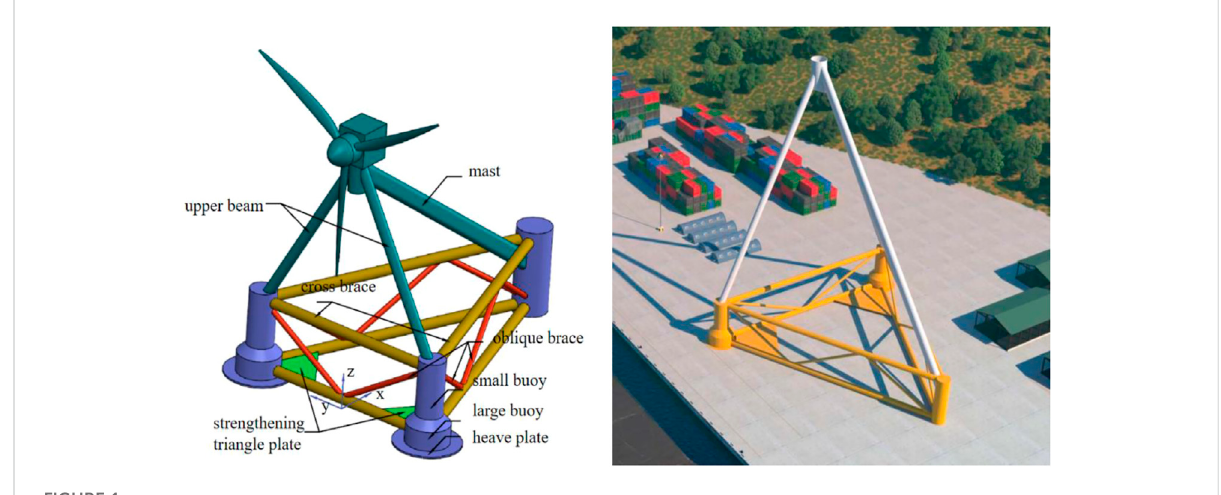
FIGURE 1 Conceptual model of the fl oating offshore wind